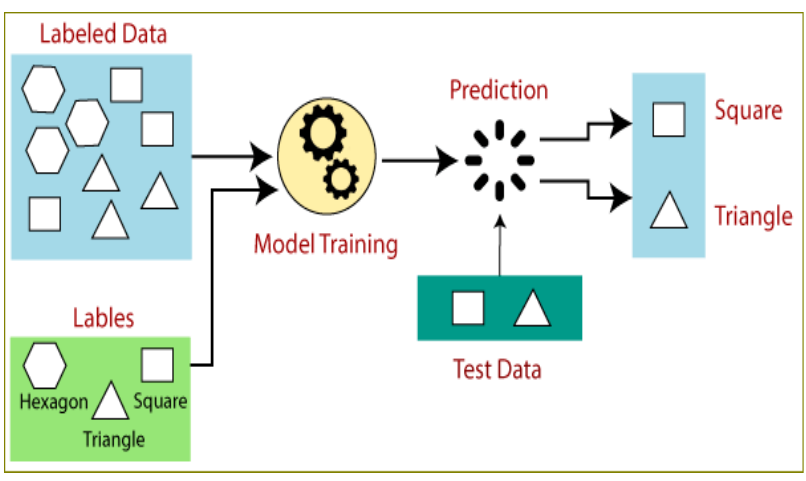
Figure 5. Supervised machine learning.